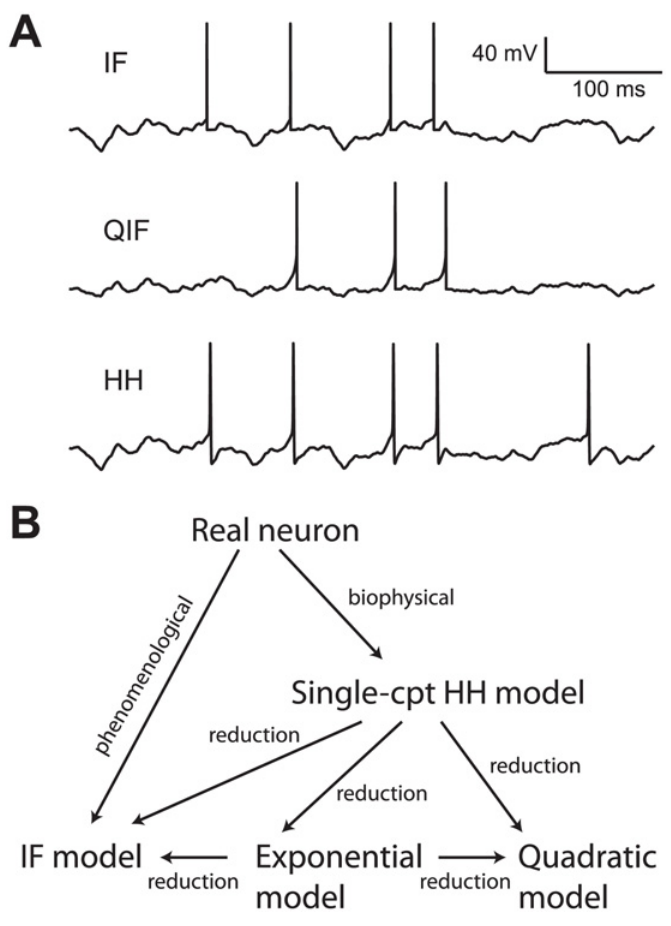
Fig 1. Single-compartment models. (A) Voltage traces of 3 models for the same input current: integrate- and-fire (IF), quadratic (QIF) and Hodgkin-Huxley (HH). The models differ mainly in their spiking responses. (B) Relationships between different single-compartment models. The IF model is a phenomenological model of spike initiation, while the HH model is a biophysical model. Other models can be obtained by reduction, i.e., as approximations of one of the above models under specific